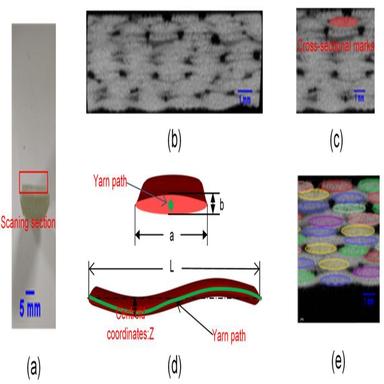
Marks of yarn cross-section: (a) Sample; (b) Yarn cross-section; (c) Cross-sectional marks; (d) Measurement of yarn cross-section parameters; (e) Mark result.